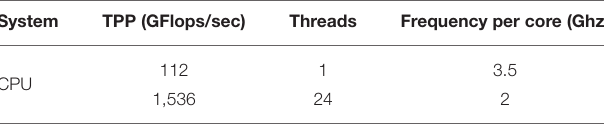
TABLE 1 | Theoretical peak performance (TPP) for a particular